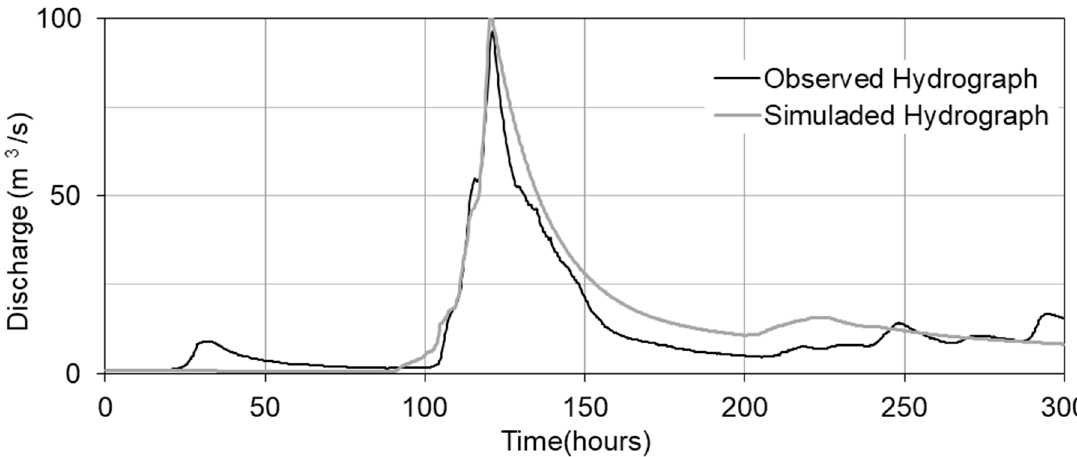
Figure 10. Hydrographs observed and simulated at the Isaba stream gauge (A268).